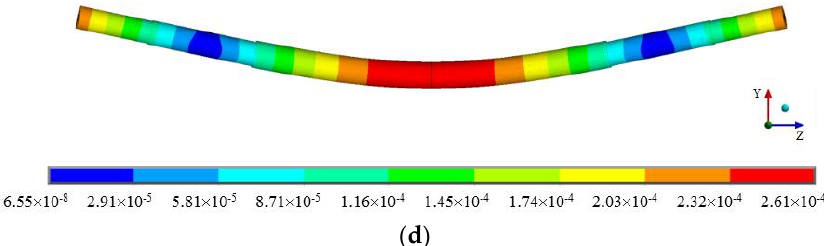
Figure 19. Equivalent stress contour of the main shaft under Q des (Unit: Pa). Figure 18. Displacement contour of the main shaft under Q des (Unite: m, magnification factor: 250): ( a ) X direction; ( b ) Y direction; ( c ) Z direction; ( d ) Total.